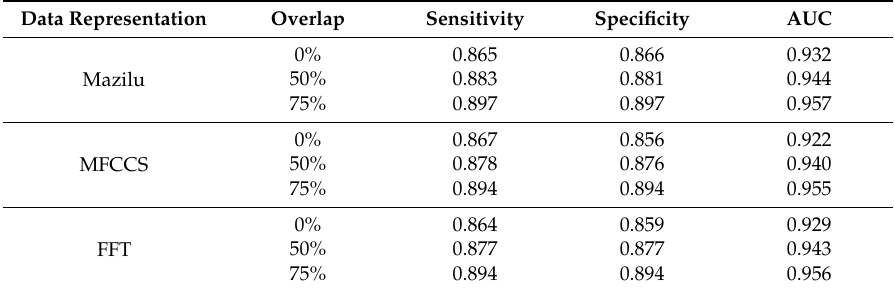
Table 3. R10Fold evaluation (personalized model) with a Random forest classifier with 100 estimators for di ff erent data representations and windows overlapping